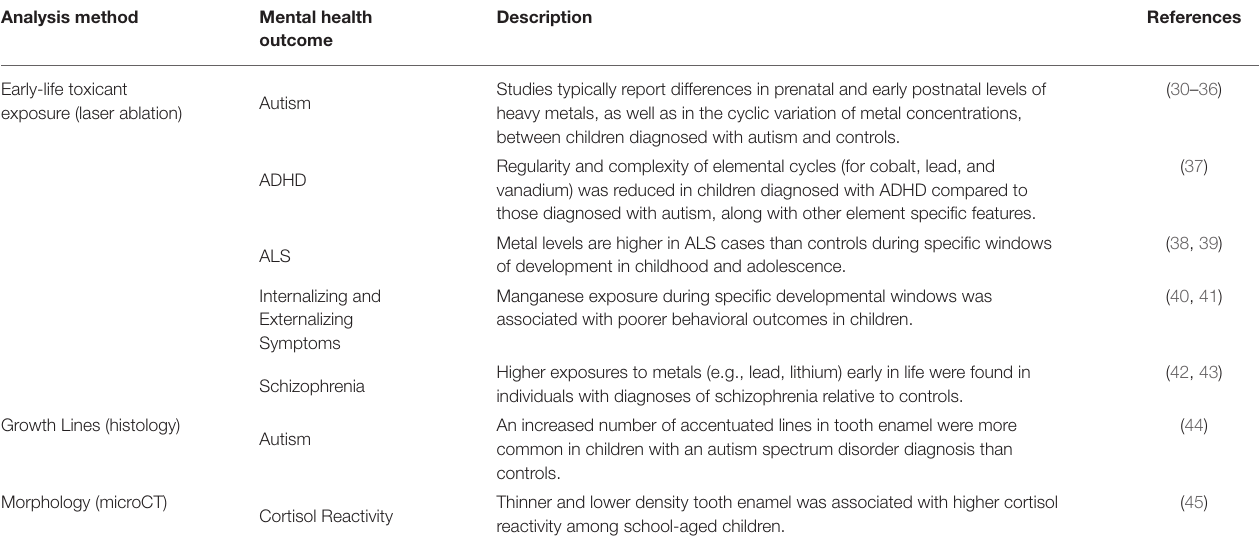
TABLE 1 | Examples of empirical research reporting associations between properties of teeth and mental health